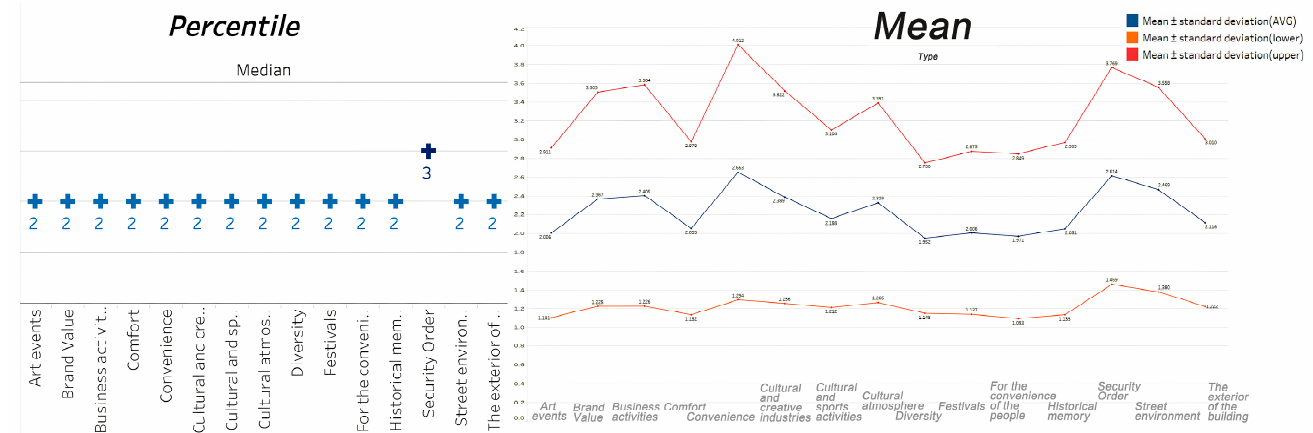
Figure 6. Analysis of average satisfaction degree for commercial space in Nonglin